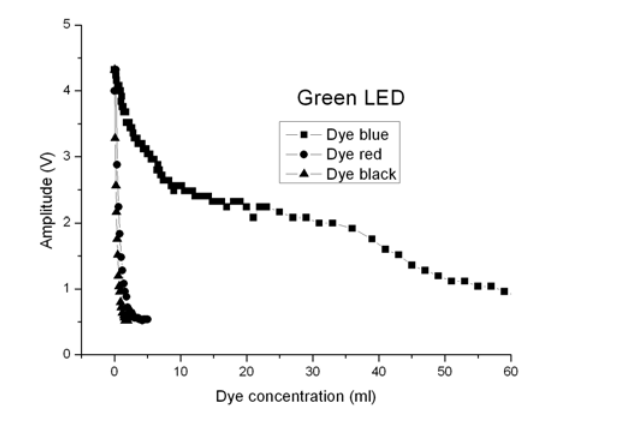
Figure 8. Tests with a green LED where λ = 530